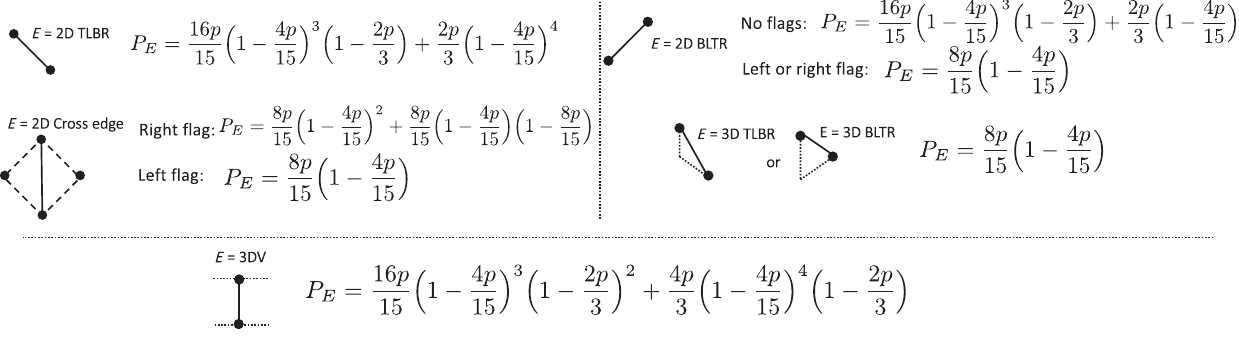
FIG. 19. Edges for the graph obtained from Z -type-stabilizer measurements of the heavy-hexagon code [Figs. 5(b) and 5(c)] and their associated probabilities to leading order in p . The label TLBR should be read as top left to bottom right. Similarly, the label BLTR should be read bottom left to top right. The cross edge is activated only when a left or right flag occurs. Lastly, 3DV is the vertical edge associated with measurement errors in the syndrome measurement